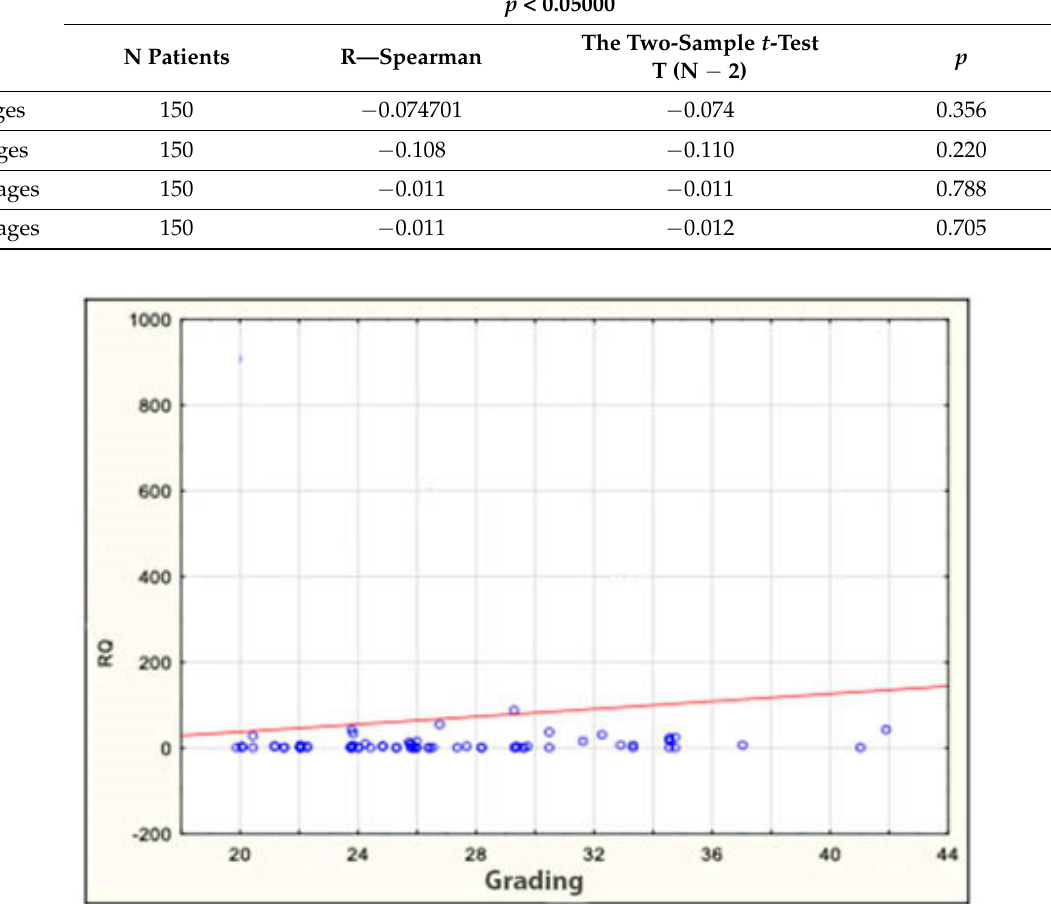
Figure 2. Correlation between miRNA ‐ 143 and grading in patients. RQ—relative quantification.